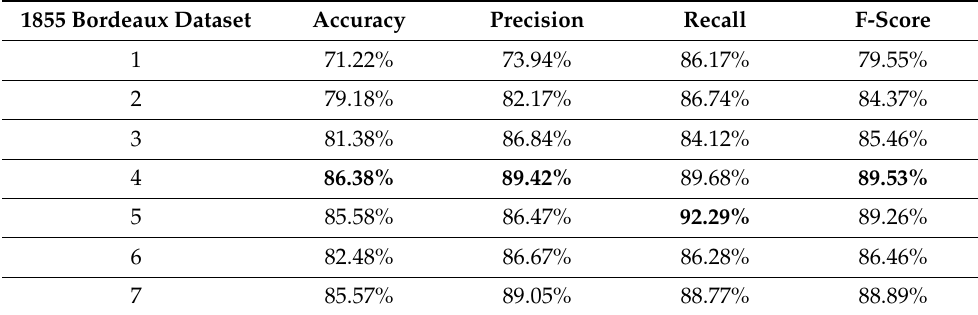
Table 6. Accuracy, precision, recall, and F-score with the SVM classifier in the 1855 Bordeaux datasets. The highest results in each column are marked in